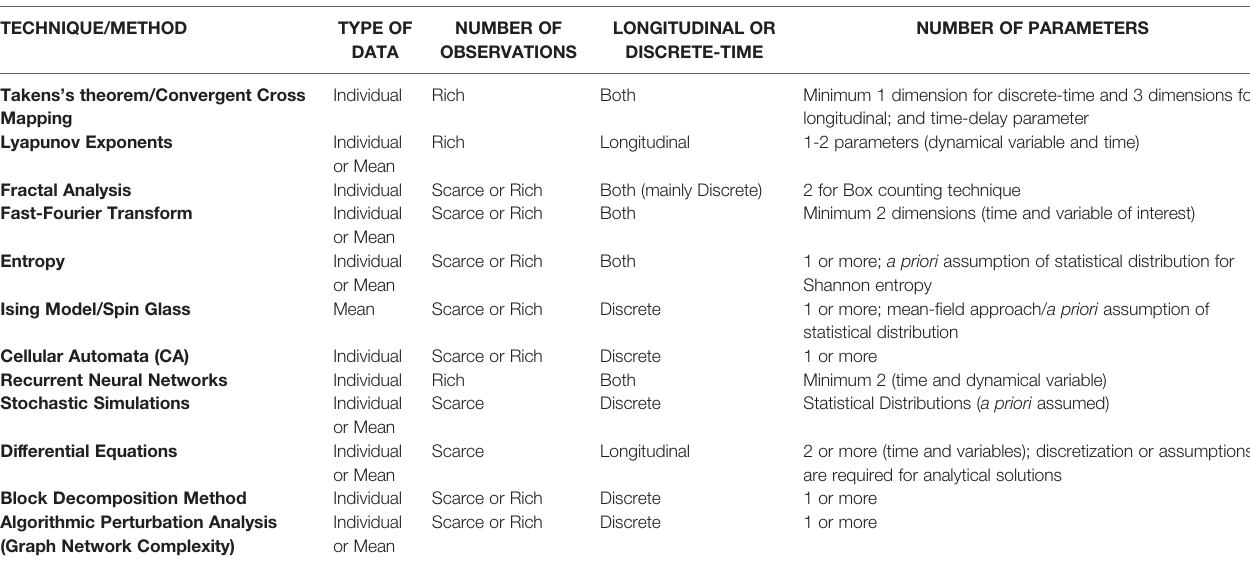
TABLE 2 | Dataset format for complex systems